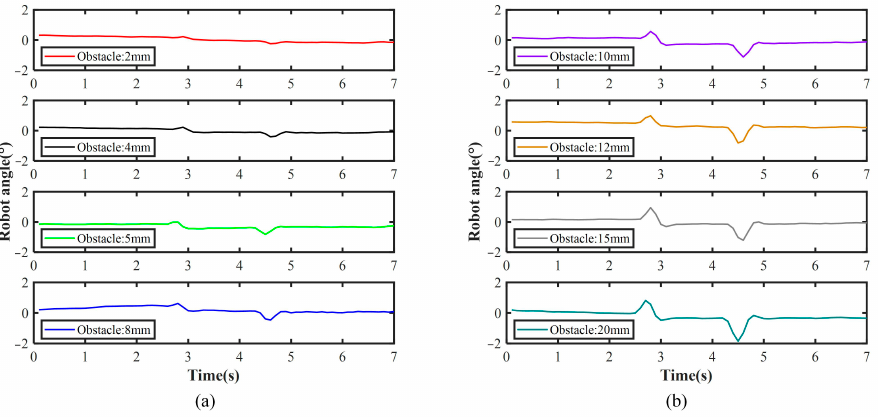
Figure 18. Robot angle in obstacle-surmounting experiments. ( a ) Obstacle height: 2–8 mm; ( b ) Obstacle height: 10–20 mm.